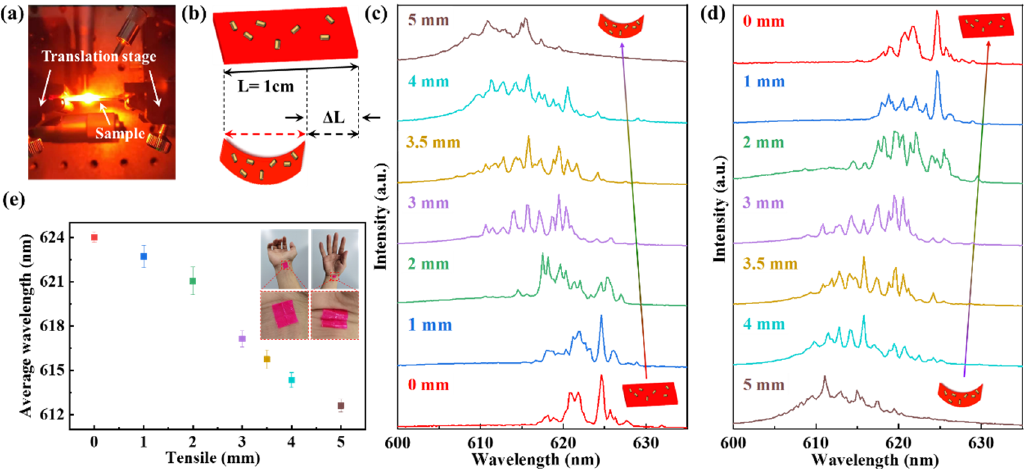
Figure 3. The optical spectrum characteristics were under the bending strain. ( a ) A schematic diagram of the experimental device was under the pumping light. The polymer film was fixed into the clip, and the translation stage can tune the curvature of a polymer film. ( b ) The schematic diagram of the principle of bending strain. The original length (L) of the polymer film was 1 cm, Δ L is the bending length when the polymer film is under bending strain. ( c , d ) The signals of the coherent random laser were detected under different bending strains. Insets exhibit schematic diagrams of a polymer film under bending and regaining state. ( e ) The blue-shifting of the average wavelength is a function of the degree of bending. Top right inset: two states of a polymer film transferred to the wrist.